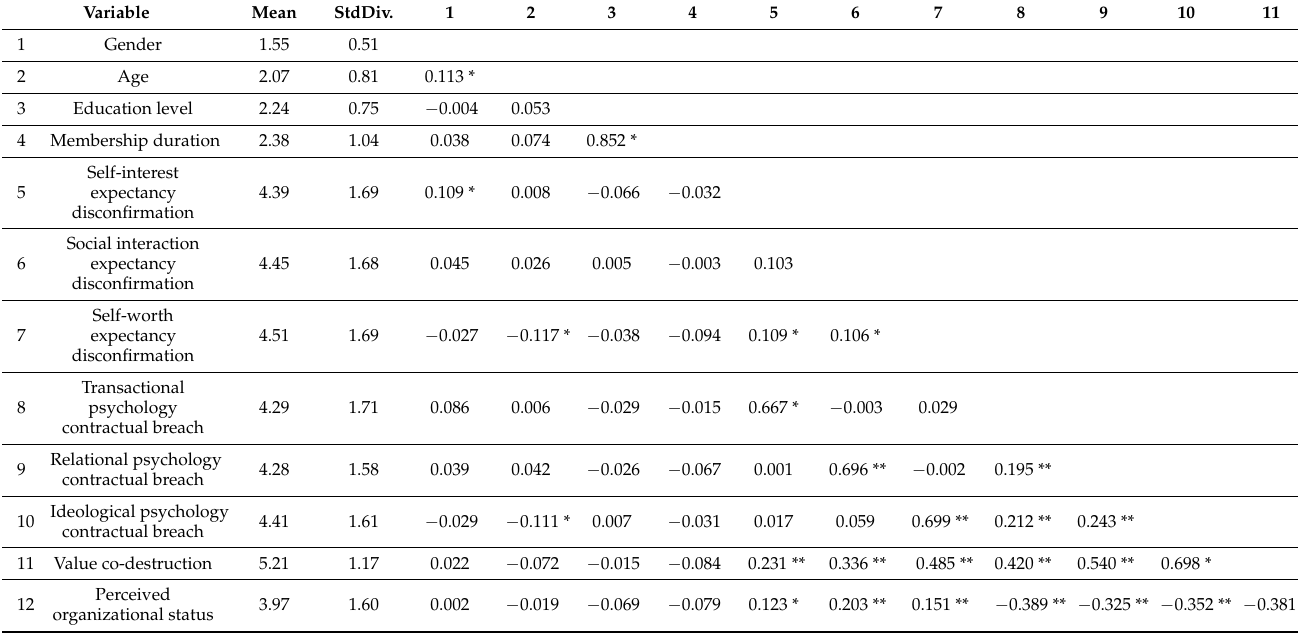
Table 5. Results of mean, standard deviation and correlation coefficient analysis for each